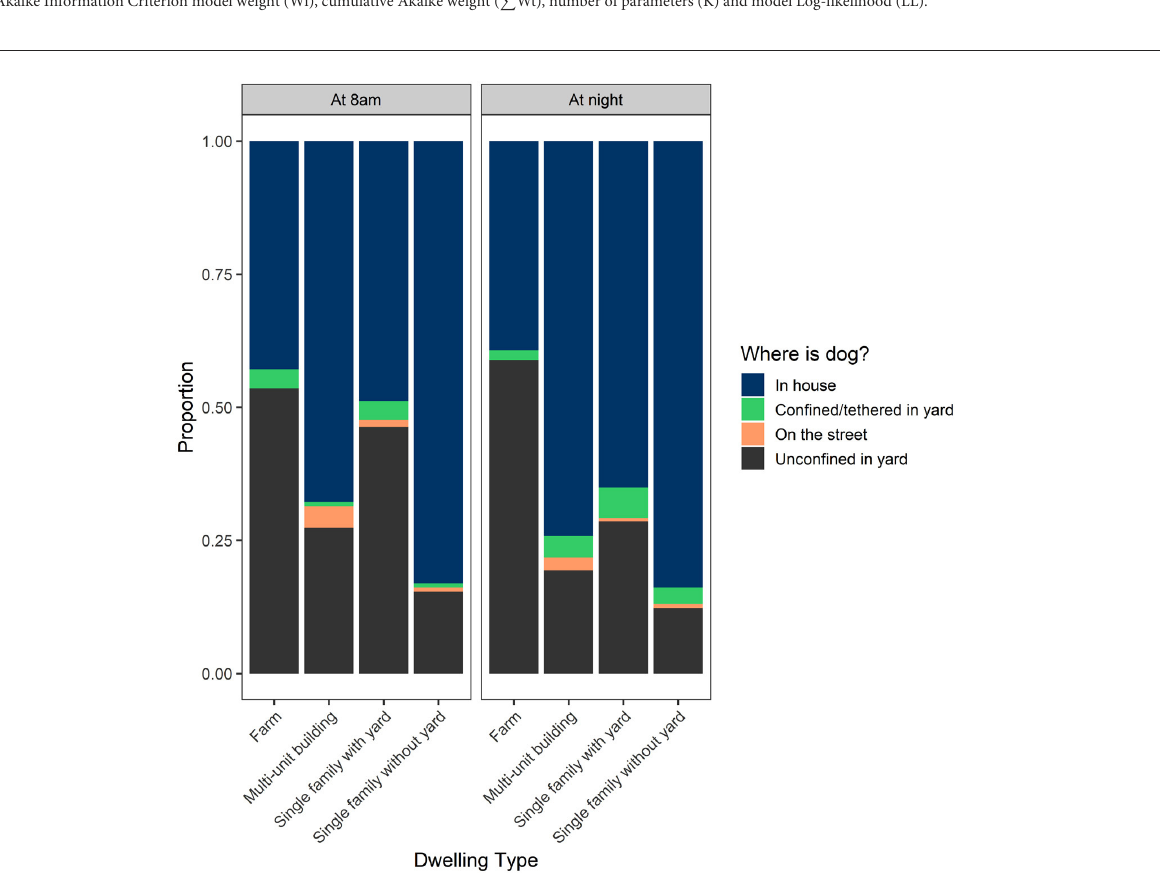
FIGURE5 Descriptive statistics of where the proportion of owned dogs in Costa Rica occur at night and at 8 am by dwelling type as reported by dog